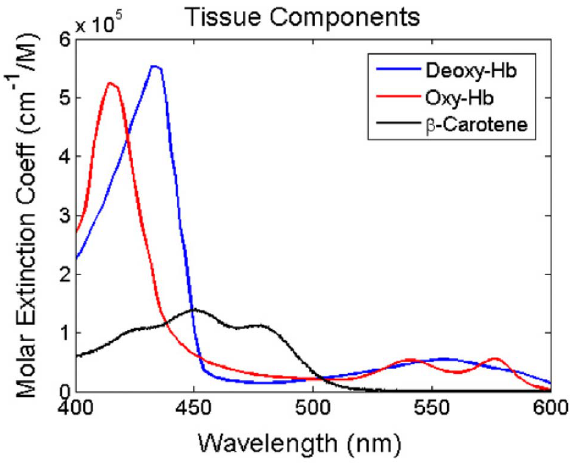
Figure 2. Dominant absorbers of breast tissue in the UV-visible spectrum. Molar extinction coefficient of oxy- and deoxy- hemoglobin and b -carotene in the 400–600 nm range.